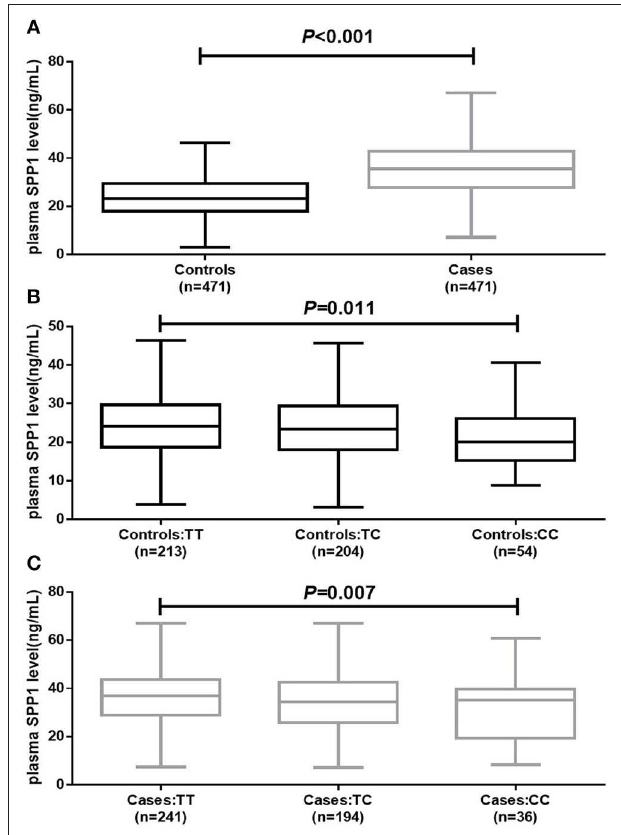
FIGURE 1 | Plasma secreted phosphoprotein-1 (SPP1) level in controls and cases. (A) Decreased plasma SPP1 level was found in breast cancer (BRC) patients compared to controls ( P < 0.001). (B) Decreased plasma SPP1 level was found in controls carrying the rs11730582 CC genotype compared with those carrying the rs11730582 TT ( P = 0.011). (C) Decreased plasma SPP1 level was found in BRC patients carrying the rs11730582 CC genotype compared with those carrying the rs11730582 TT ( P = 0.007). The upper and lower boundaries of the boxes represented the 25th and 75th percentiles of plasma SPP1 level value, and the horizontal line within the box represents the median value. All P -values were adjusted by age at diagnosis and age at